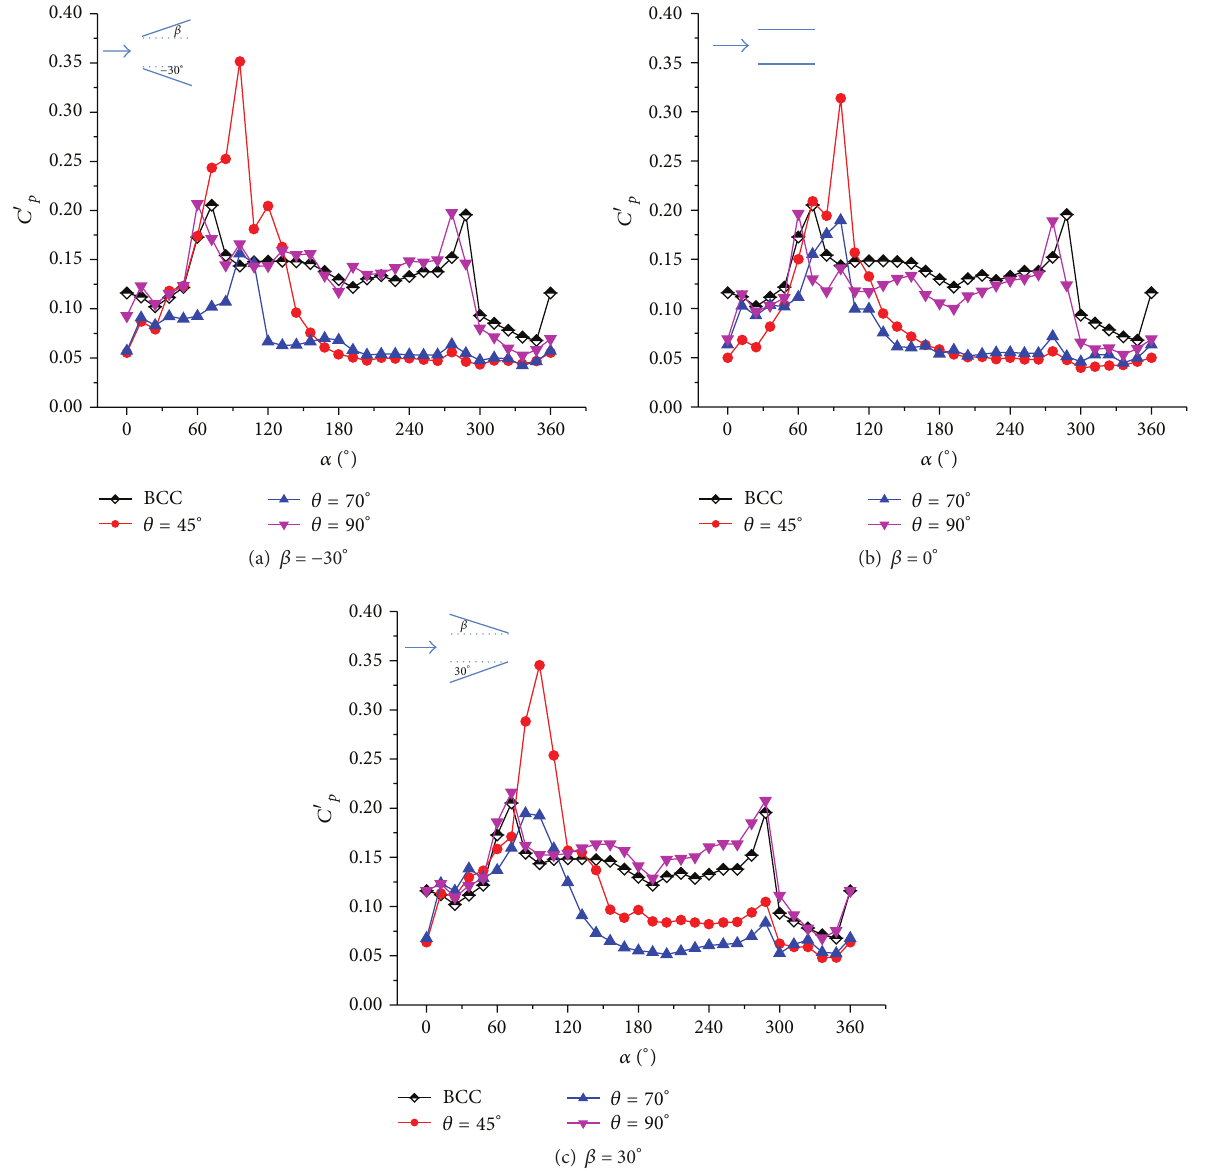
Figure 10: Distribution of the fluctuating pressure coefficients ( 𝑈𝑟 = 7